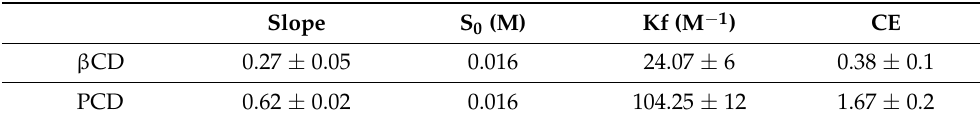
Table 1. Values of slope, binding constant (Kf), and complexation efficacy (CE) in the presence of CD and PCD.